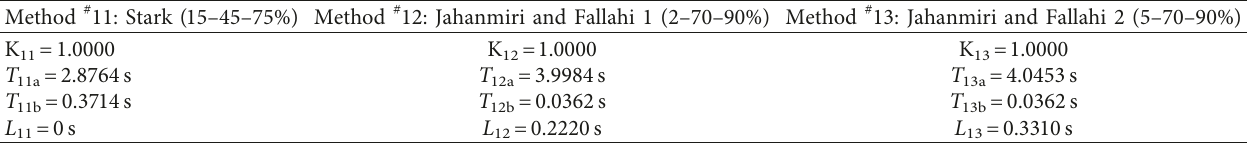
Table 17: SOPDT model parameters obtained using Stark’s and Jahanmiri and Fallahi’s three-point methods, respectively.